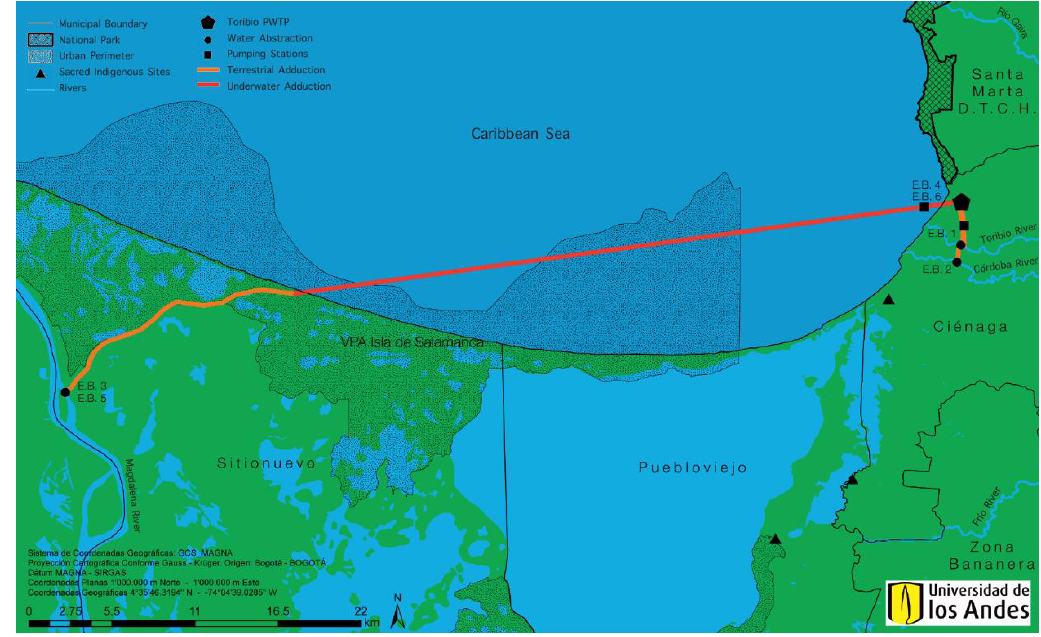
Figure 11. Selected alternative characteristics and geographical location, Adapted from [58].